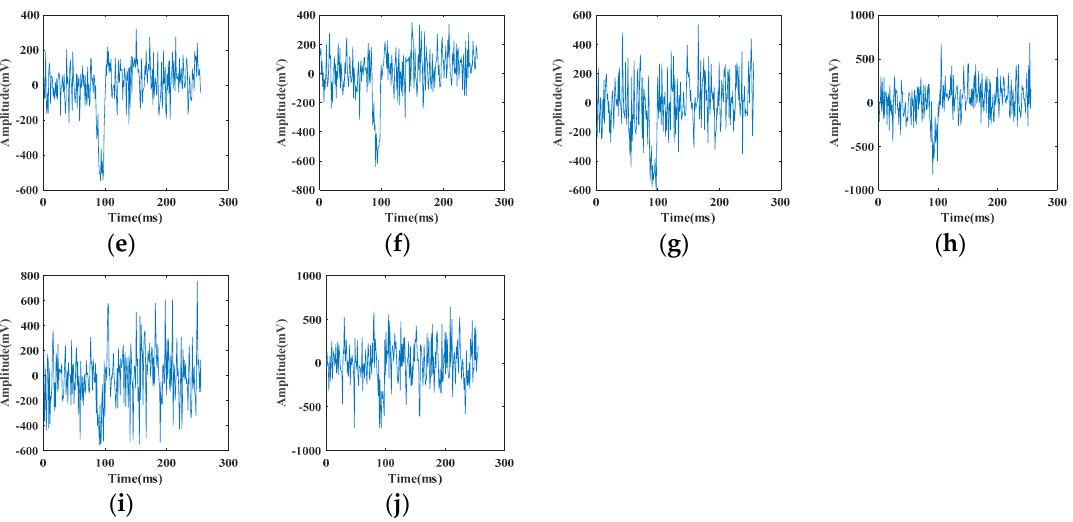
Figure 8. Pickaxe signal superimposed with white Gaussian noise according to Equation (9): ( a ) α = 20; ( b ) α = 40; ( c ) α = 60; ( d ) α = 80; ( e ) α = 100; ( f ) α = 120; ( g ) α = 140; ( h ) α = 160; ( i ) α G = 180; ( j ) α G =